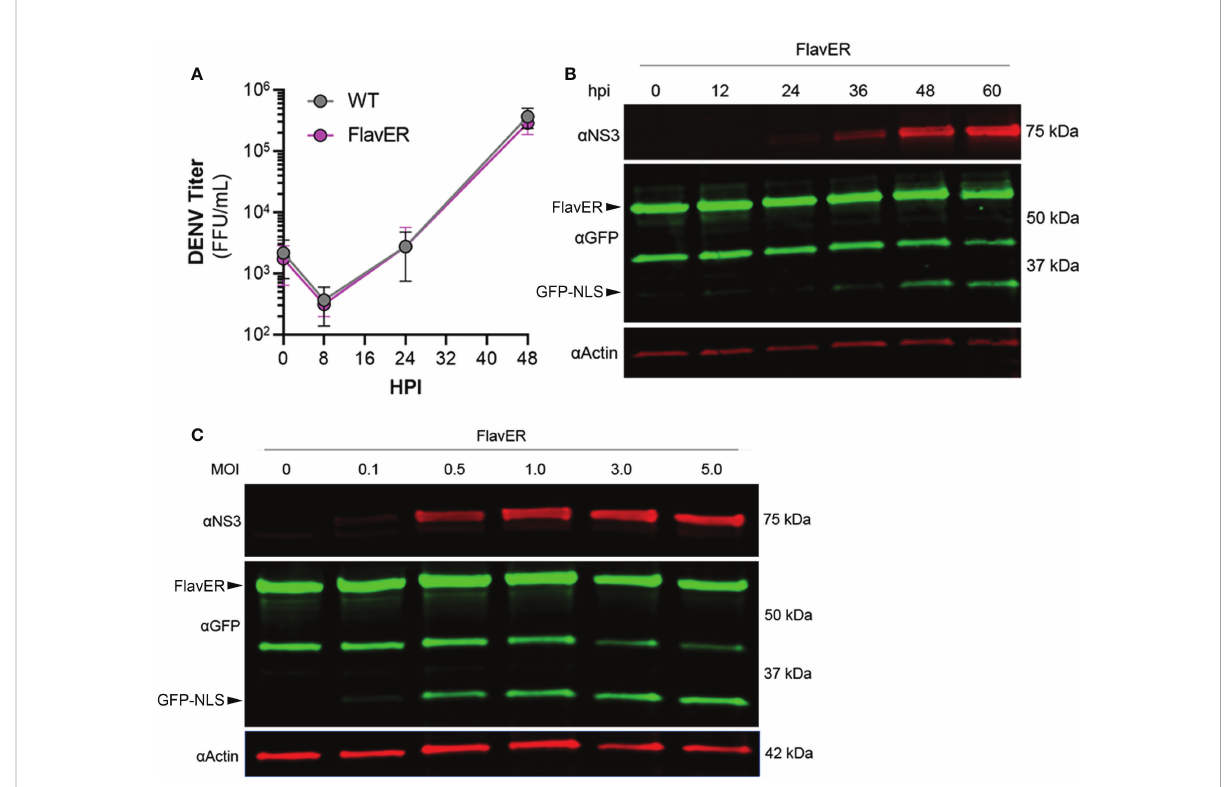
FIGURE 3 FlavER validation with DENV infection. (A) Growth kinetics of DENV in wildtype and FlavER-expressing Huh7 cells. Huh7 cells were infected with DENV at an MOI of 0.1, and FFU assays were performed on supernatants collected at the indicated time points, n=3. Data points represent the average titer (FFU/mL) for three independent experiments. (B) Immunoblot for NS3, GFP, and actin of U2OS cells stably expressing FlavER, infected with DENV at an MOI of 0.1, and lysed at the indicated hour post infection. (C) Immunoblot for NS3, GFP, and actin of U2OS cells stably expressing FlavER and infected with the indicated MOI of DENV. Cell lysates were harvested 24 hours post